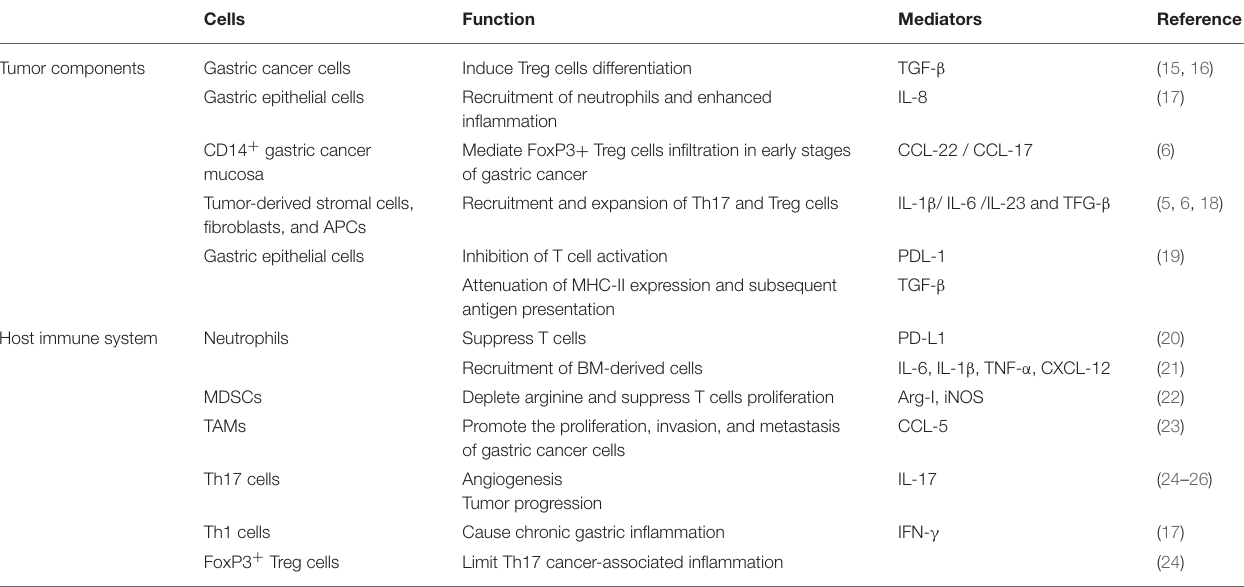
TABLE 1 | Cellular components of gastric cancer